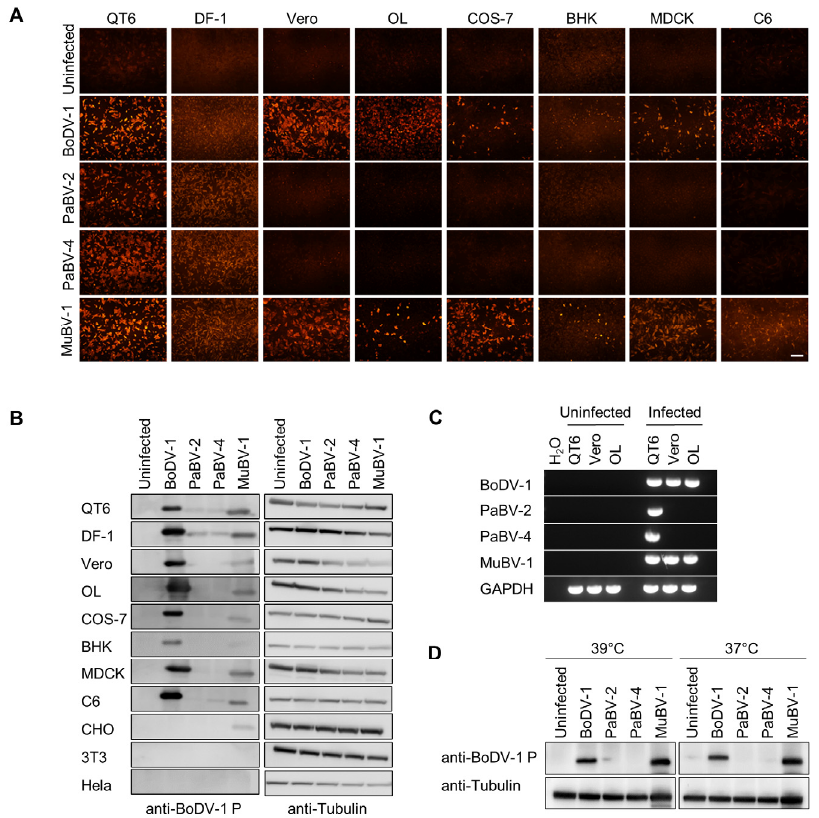
Figure 1. Clade-dependent host specificity of orthobornaviruses. ( A ) Host cell-dependent infection of orthobornaviruses. Orthobornaviruses from each clade (clade 1, Borna disease virus 1 (BoDV-1); clade 2, munia bornavirus 1 (MuBV-1); clade 3, parrot bornavirus 2 (PaBV-2) and PaBV-4) were inoculated into the indicated cell lines, and 14 days after infection, indirect immunofluorescence assay (IFA) was performed with an anti-BoDV-1 P antibody. Bars, 100 µ m. ( B ) Detection of P antigens in orthobornavirus-infected cell lines by Western blotting. Cell lysates were collected 14 days post infection. Anti-Tubulin was used as the loading control. ( C ) Detection of viral RNAs by RT-PCR. Total RNA was extracted from inoculated cells, and RT-PCR was performed by using M-specific primers for each genotype. ( D ) Temperature-dependent replication of orthobornaviruses in mammalian cells. Vero cells were inoculated with clade 1, clade 2 and clade 3 viruses and incubated at 37 or 39 ◦ C, and viral replication was detected by Western blotting using an anti-BoDV-1 P antibody.